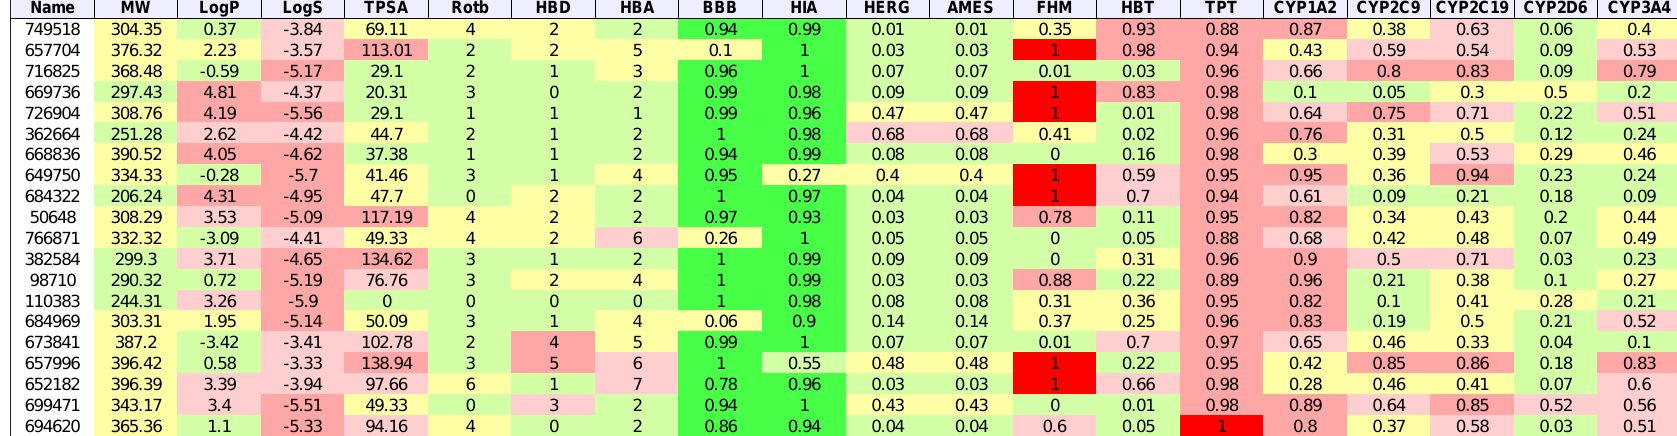
Table 4. Breast cancer: List of physio-chemical properties and predicted toxicology and ADME for top 20 ligands. Toxicology and ADME predictions are probabilities in the range [0, 1] *.